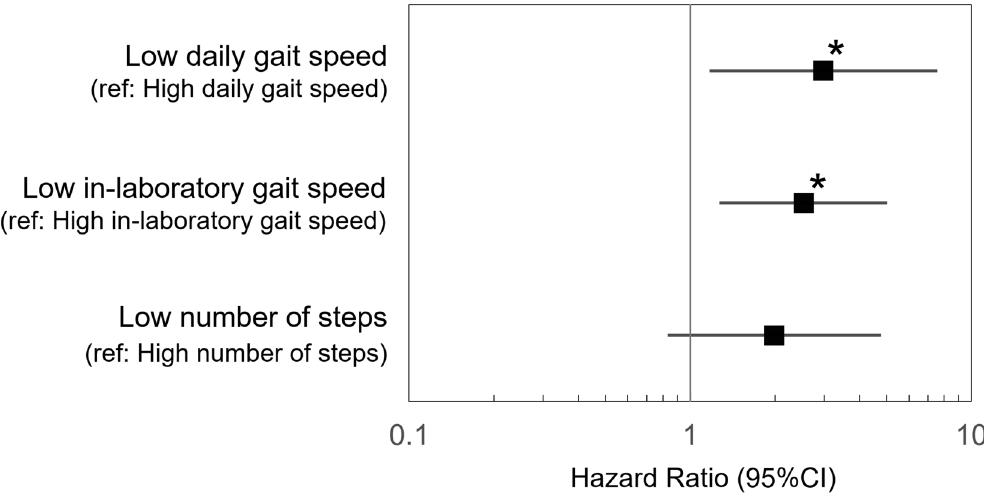
Figure 2. Hazard ratios (HRs) and 95% CIs for the three gait parameters (daily gait speed, in-laboratory gait speed, and number of steps) in the adjusted model. * p <